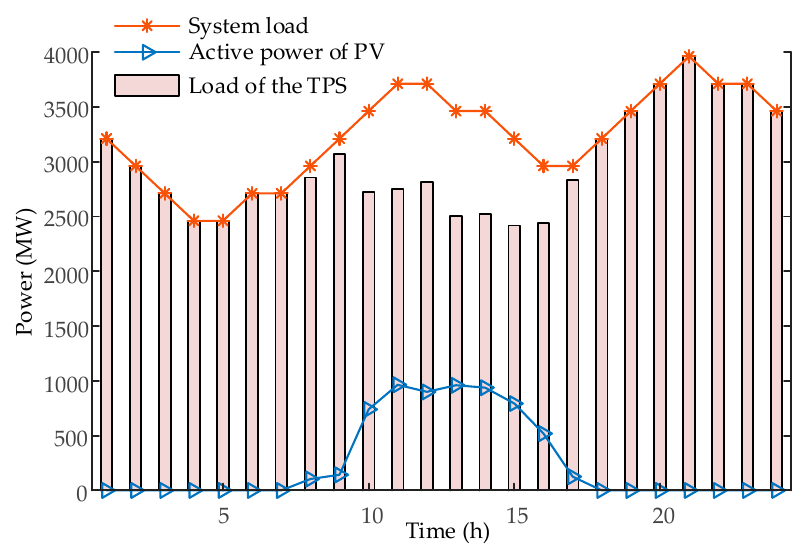
Figure 6. The load curve and the distributed PV active power curve.